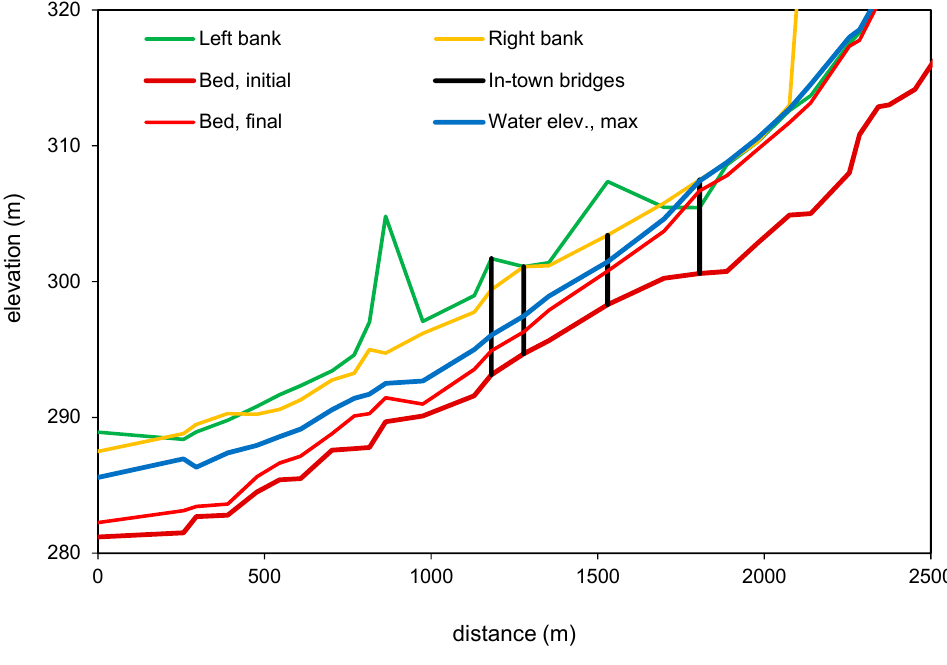
Figure 13. Results (thalweg and free surface profiles) for the simulation of the design event.